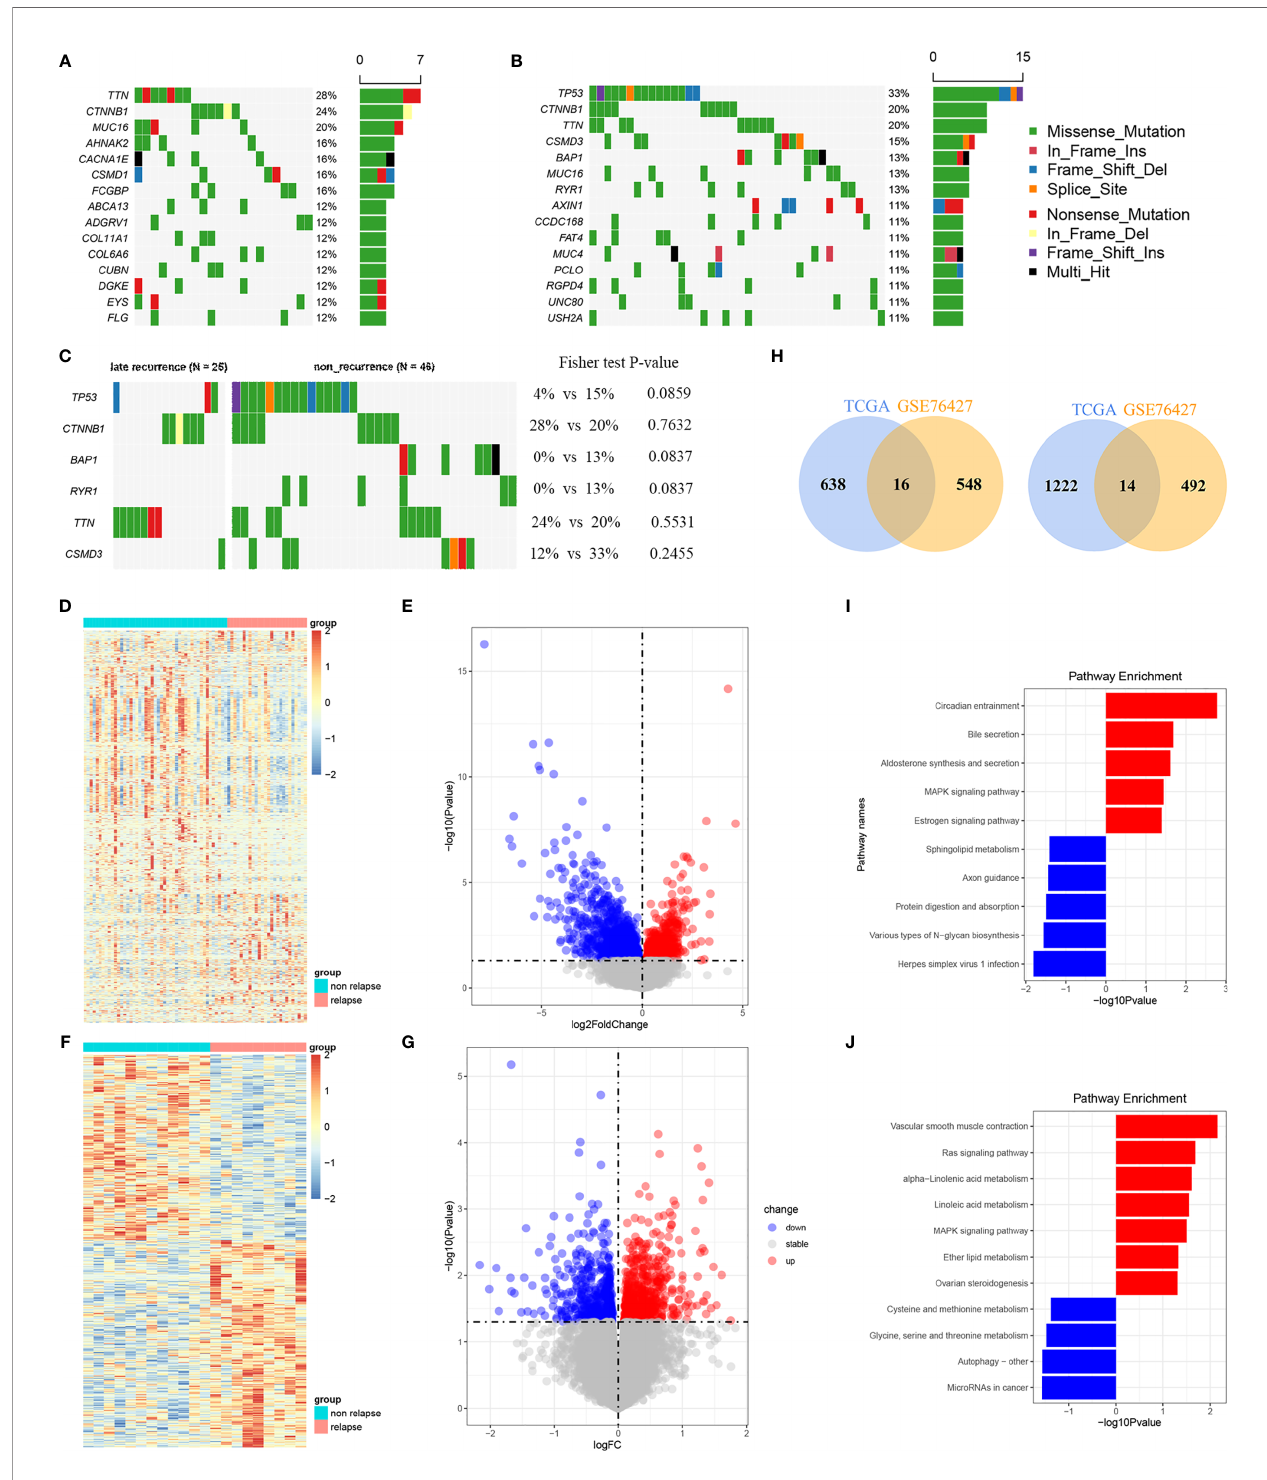
FIGURE 1 | Analyses of somatic mutation pro fi les in HCC samples and fi ltration of LR-related genes. (A, B) Waterfall plot of detailed mutation information for top 10 genes in the 23 and 46 HCC patients with LR (A) and 46 with NR (B) , respectively. (C) Waterfall plot of the different mutation genes between LR- and NR-HCC. (D, E) The heatmap (D) and volcano plots (E) of LR genes in the TCGA-LIHC. (F, G) The heatmap (F) and volcano plots (G) of LR genes in the GSE76427 cohort. (H) The Venn diagrams of the down and up overlap genes. (I) The KEGG enrichment analysis between LR- and NR-HCC in the TCGA cohort. (J) The KEGG enrich analysis of the common LR-related